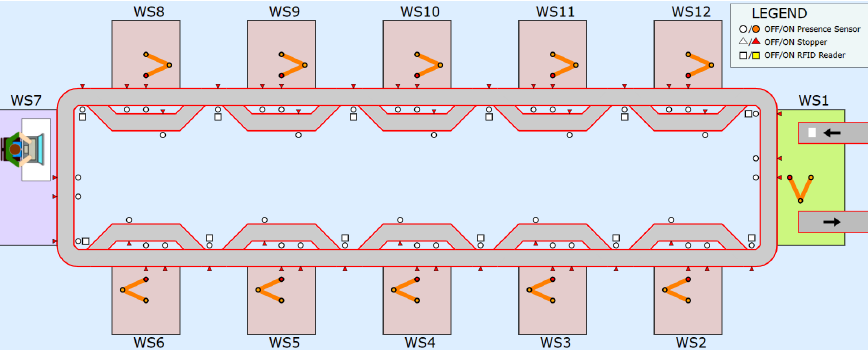
Figure 10. FASTory assembly line layout. [Source: Snapshot from the FASTory Simulator [1]].